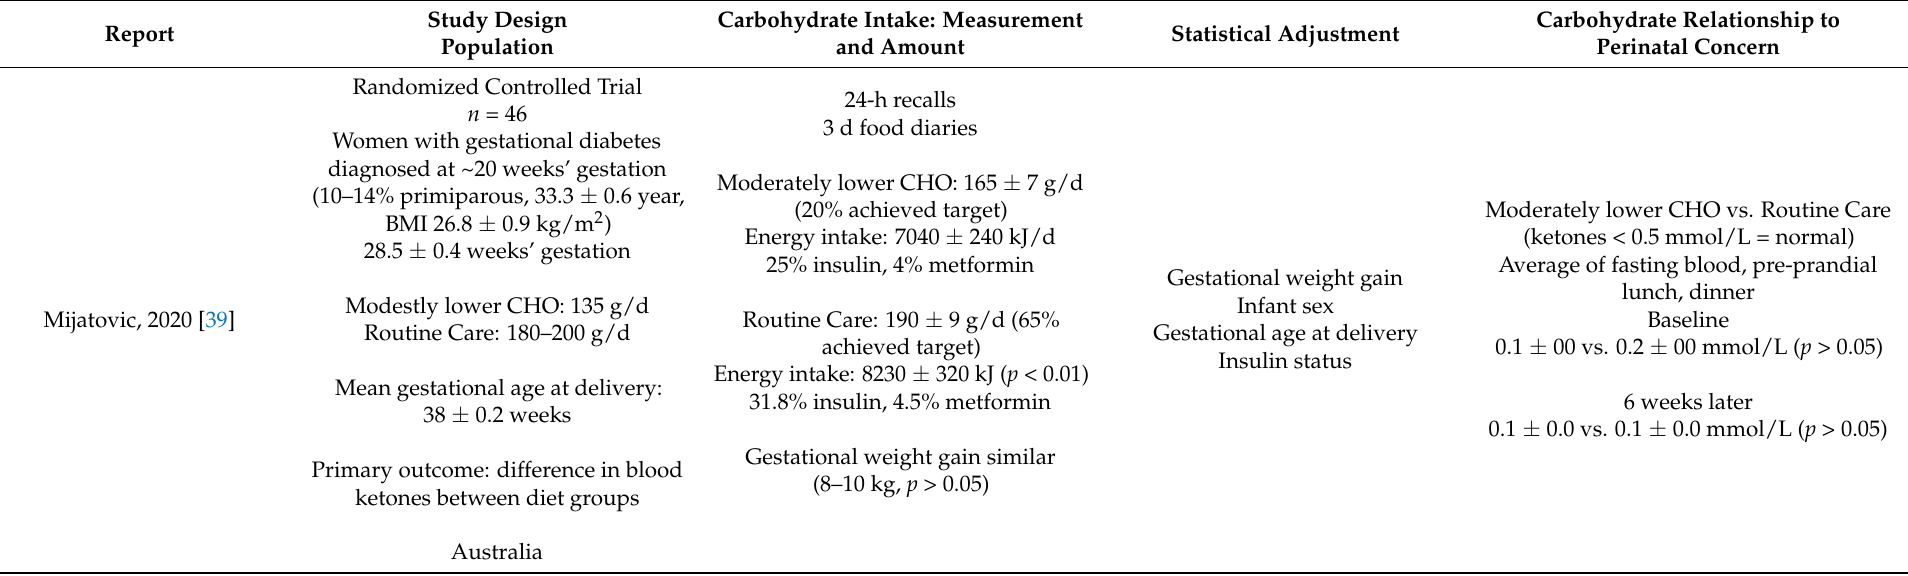
Table 2. Reports relevant to research question 2: In pregnant women who consume a LC diet, is there greater fetal exposure to maternal